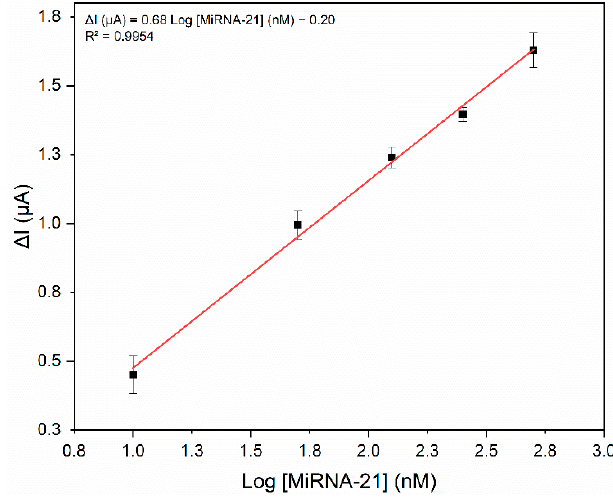
Figure 9. Calibration curve of ∆ I value of current response of MB as a function of different microRNA-21 target concentration (from 1.0 × 10 − 8 to 5.0 × 10 − 7 M). The concentration of the capture probe was 1 µM. Measurements (DPV) were done in Tris–HCl buffer (20 mM, pH 7.0) including 20 mM of NaCl.